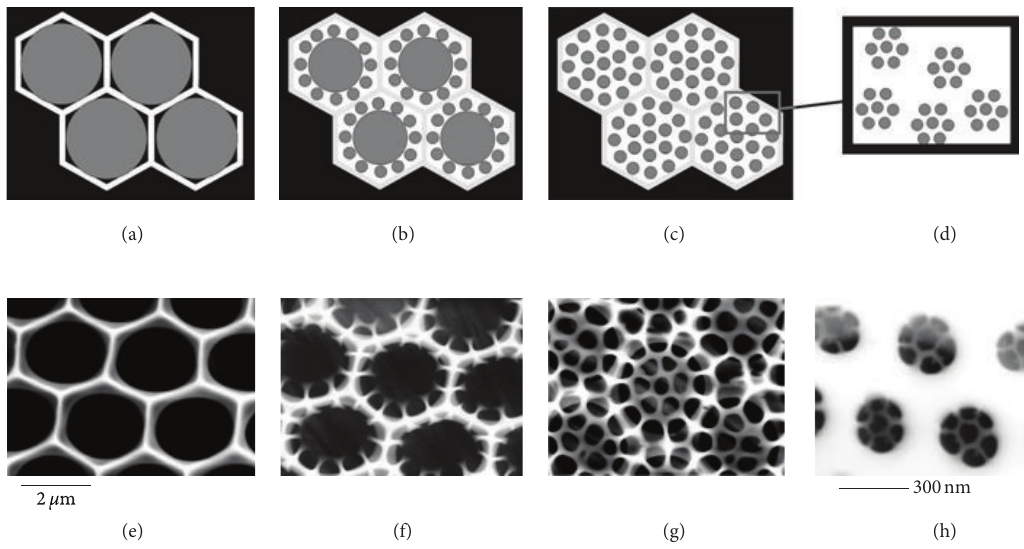
F 7: Templating of diatom cell wall structure by the physical-chemical properties of long-chain polyamines within the silica-deposition vesicle in the phase separation model. (a)–(d) are models and (e)–(h) are scanning electron micrographs of the silaffin-free diatom C. wailesii valves at different stages of growth. (a) A monolayer of LCPA droplets in a hexagonal arrangement. (b) and (c): Stepwise segregation into smaller droplets provides new locations for silica precipitation to the �nal dispersion into 50-nm droplets. Silica precipitation takes place within the water phase (white areas). Reproduced with permission from